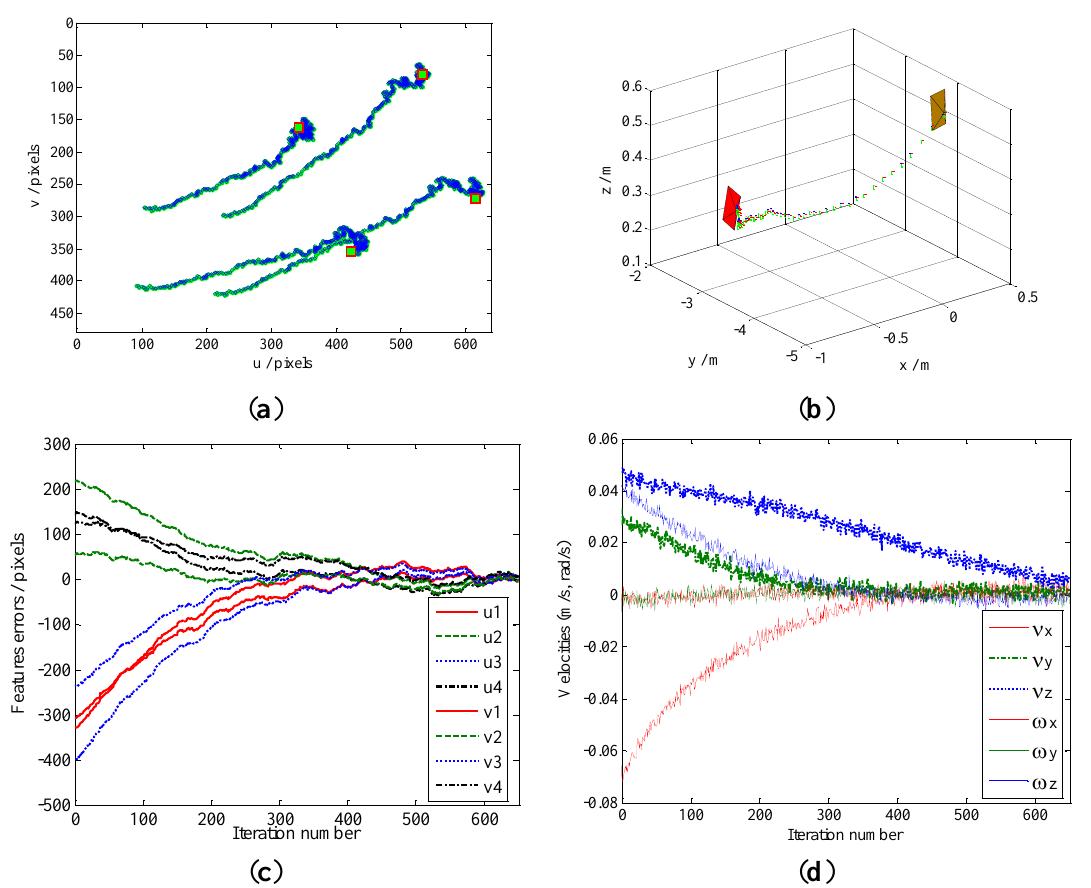
Figure 16. Experimental results obtained by our method for Case 3 translational and rotational movement. ( a ) Feature point trajectories; ( b ) Camera trajectory; ( c ) Feature errors; ( d ) Camera